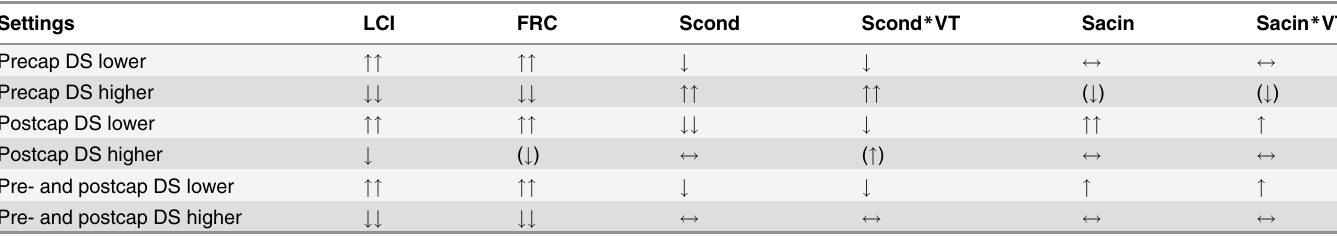
Change of N 2 MBW test results of 30 children after simulation with changed apparatus dead space (pre-capillary dead space (precap DS), post-capillary DS (postcap DS) and both). Results of standard N 2 MBW test were compared to the test with changed setting parameter by Wilcoxon signed-rank test